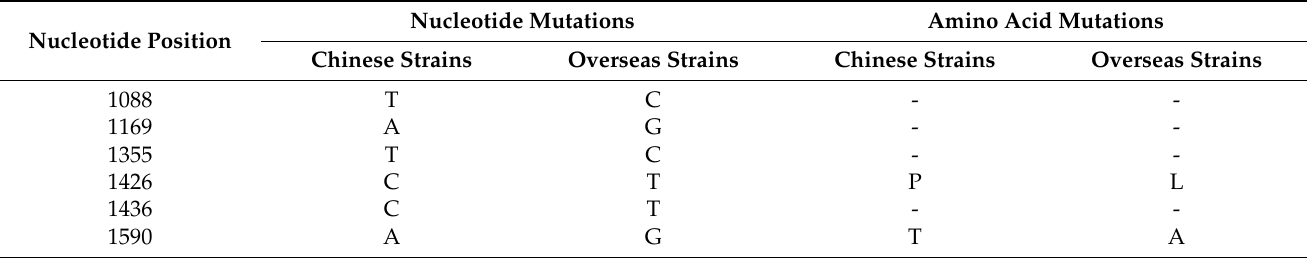
Table 3. Nucleotide and amino acid differences between the complete genomes of the Chinese strains in this study and all BPIV3 genotype C overseas